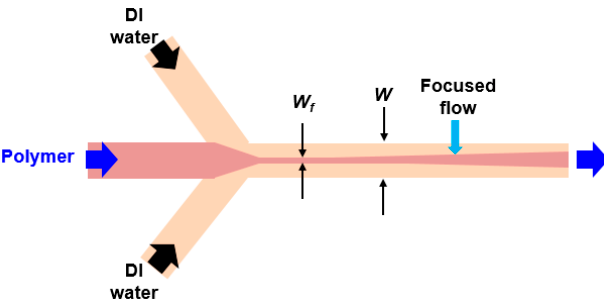
Figure 3. Schematic of hydrodynamic focusing flow.